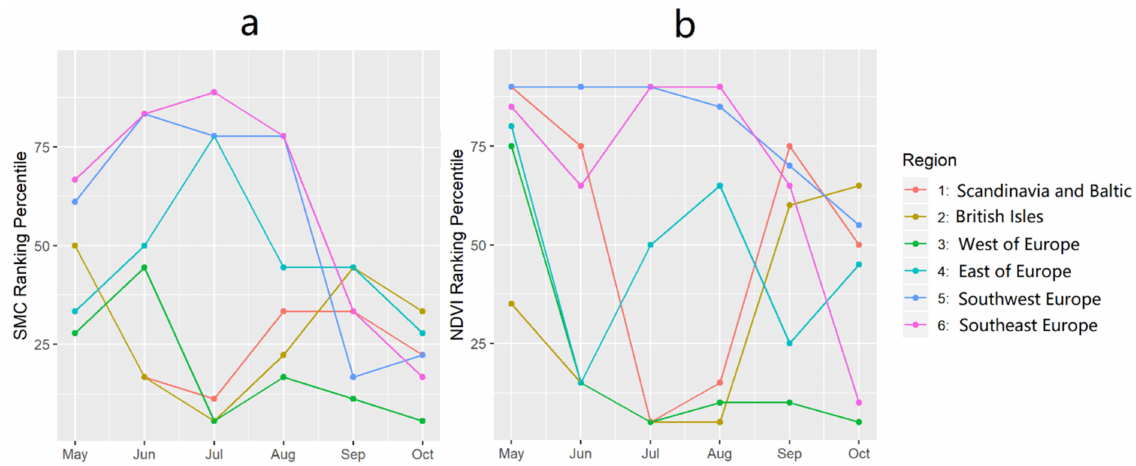
Figure 2. Region average development of ( a ) SMC and ( b ) NDVI in 2018. The spatial extent of the regions is shown in Figure